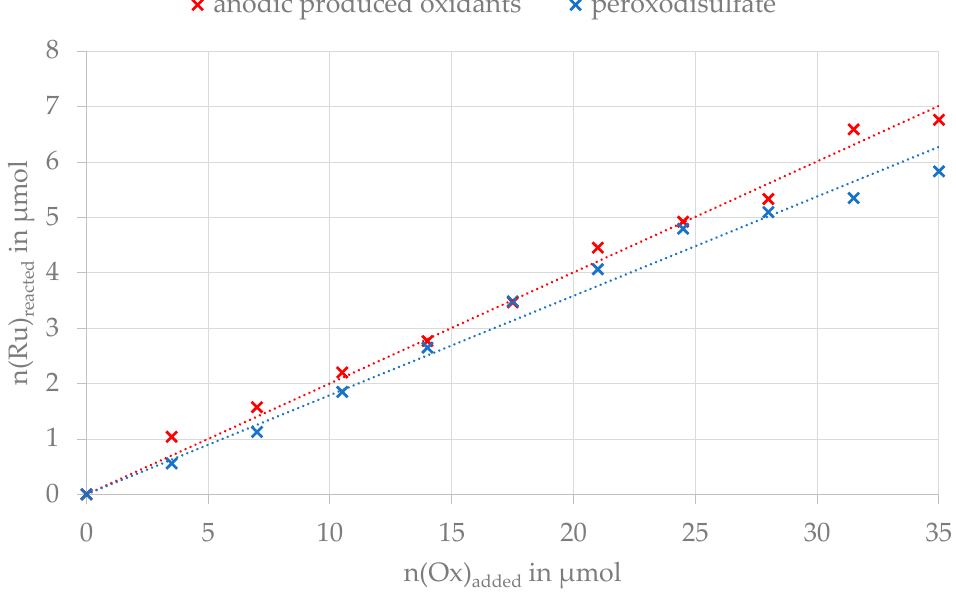
Figure 9. Dependence of the oxidized ruthenium quantity (n(Ru) reacted ) on the oxidizing agent addition (n(Ox) added ).